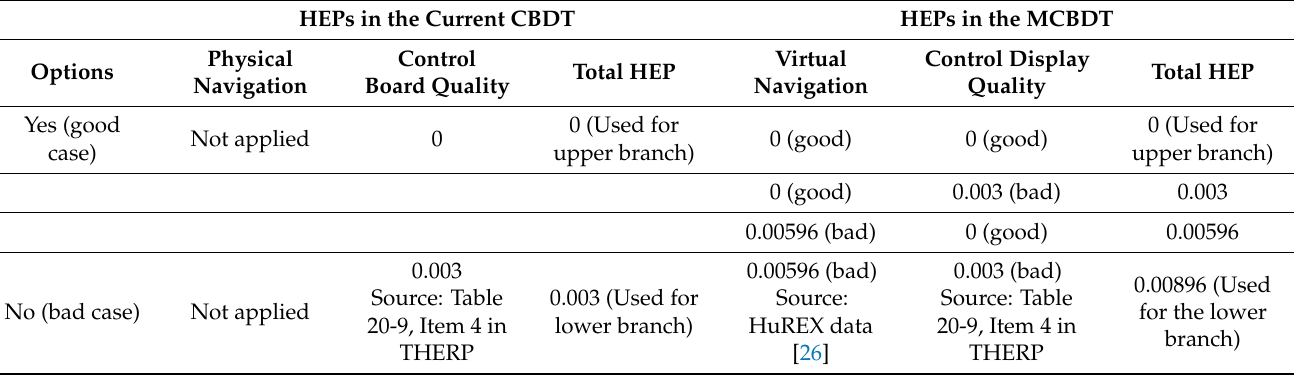
Table 6. Evaluating “indicator easy to locate” on the Pcc